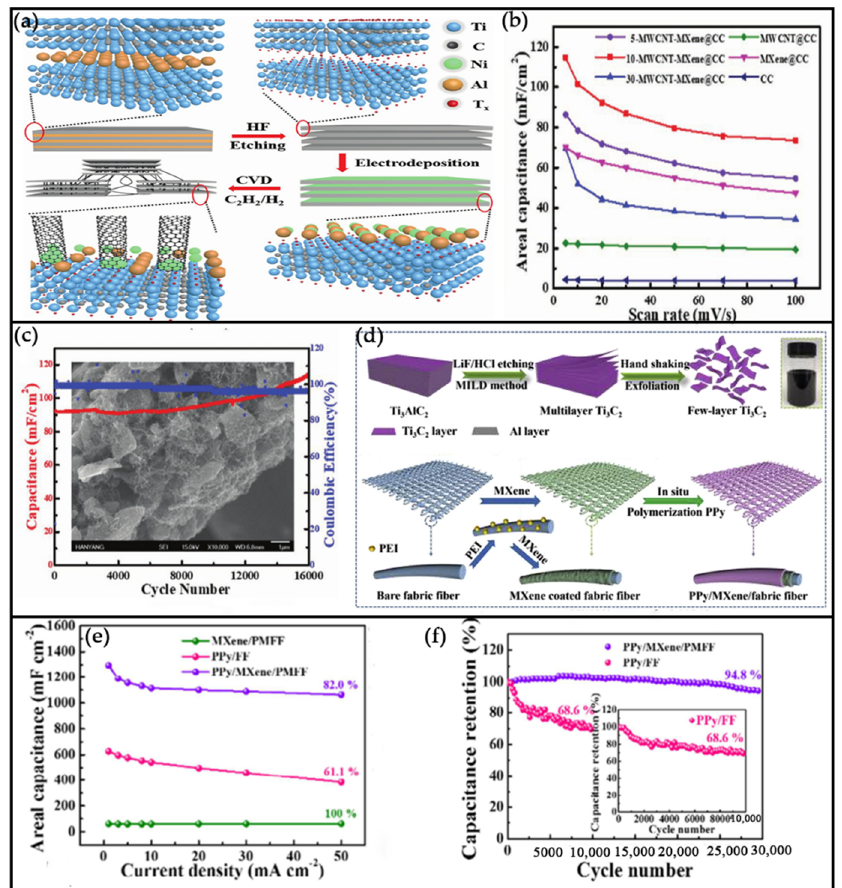
Figure 14. ( a ) Schematic illustration for the preparation of MXene and MWCNTs. ( b ) Areal specific capacitance of different samples at different scan rates. ( c ) Cycling stability of 10−MWCNT−MXene@CC electrode at a current density of 10 mA cm −2 . Reprinted with permission from Ref. [185]. Copyright 2020 WILEY-VCH Verlag GmbH & Co. KGaA. ( d ) Schematic illustration of the synthesis process for a MXene and PPy/MXene/PMFF textile electrode. ( e ) Areal capacitance comparison of the samples at different current densities. ( f ) Cycling performance of PPy/FF and PPy/MXene/PMFF measured at 30 mA cm −2 , with enlargement of cycling performance of PPy/FF in the inset. Reprinted with permission from Ref. [186]. Copyright 2020 Energy Storage Materials .